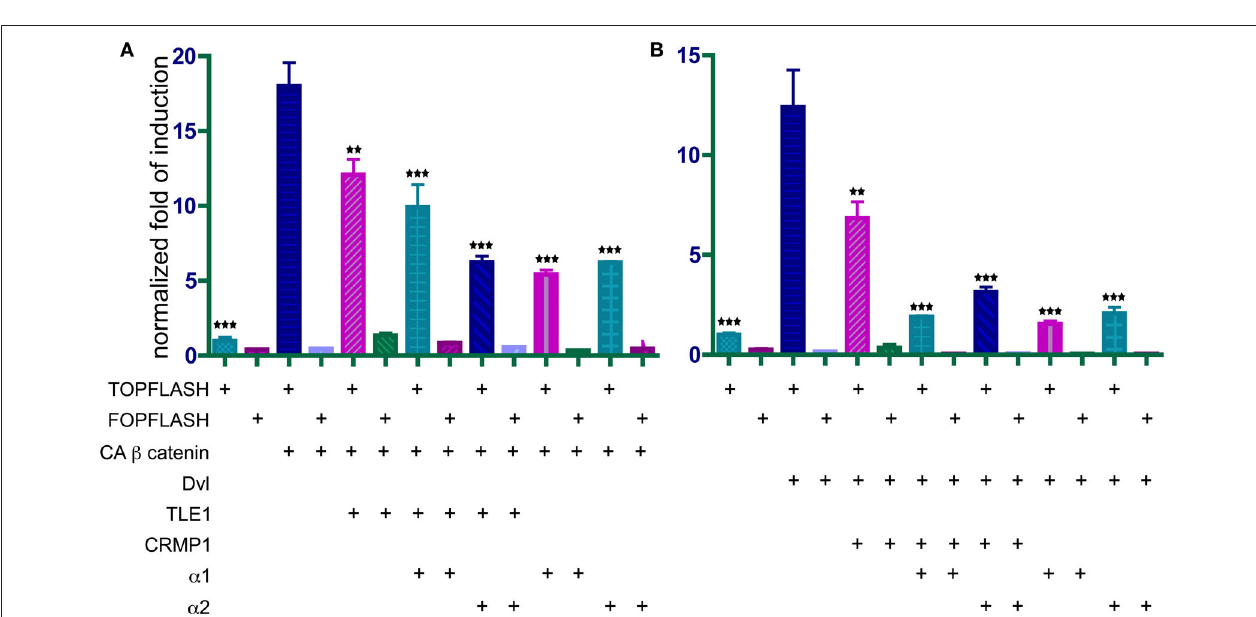
FIgure 2 | Positioning of PAH-AH in the Wnt pathway. PAF-AH (highlighted in yellow) interacting proteins (highlighted in light blue) connected with green lines were detected in a large yeast two hybrid screen, additional interactions are connected by orange lines (Stelzl et al., 2005) and associated site: